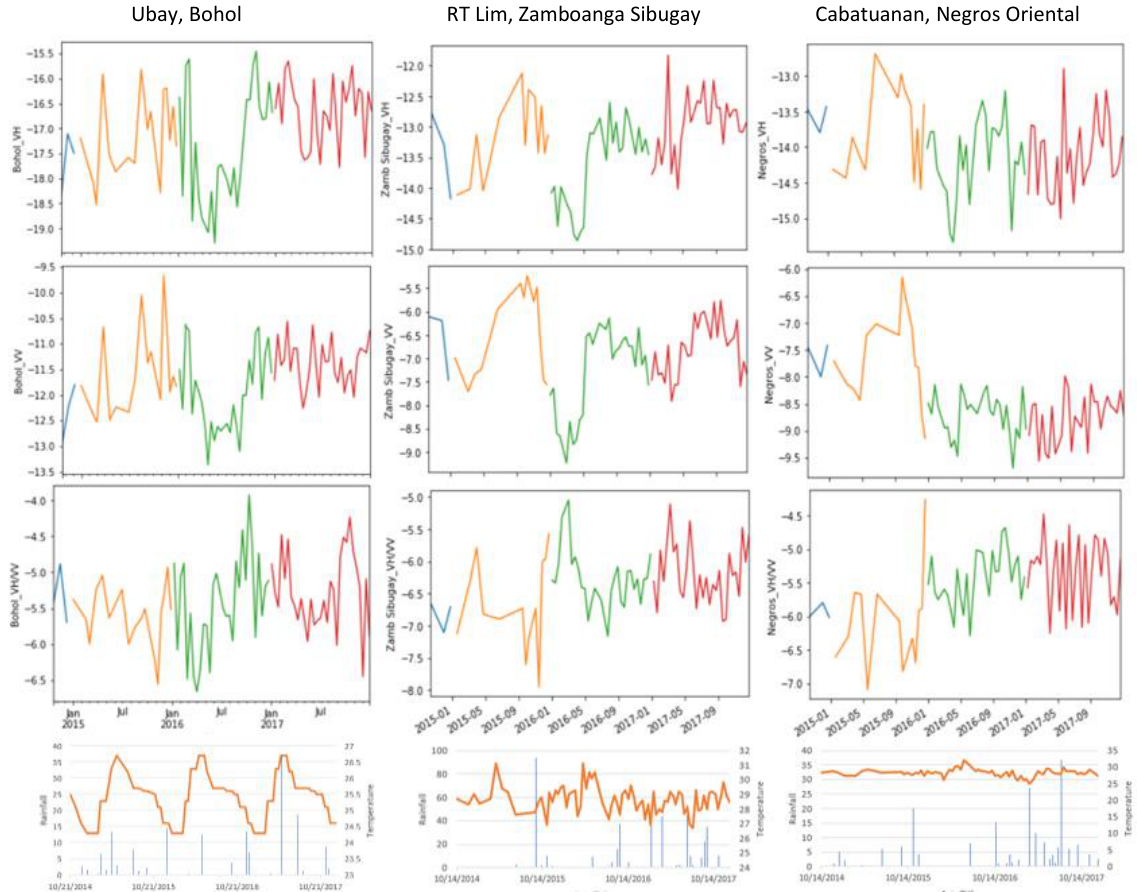
Figure 9. (From left) Temporal signature of Bohol, Zamboanga Sibugay, and Negros Oriental NGP sites. Provided are (from top to bottom) their plots in VH (dB), VV(dB), VH/VV, rainfall (mm), and temperature (Celsius). The temporal signature for VH, VV, and VH/VV are grouped and color-coded by year: blue (2014), yellow (2015), green (2016), and red